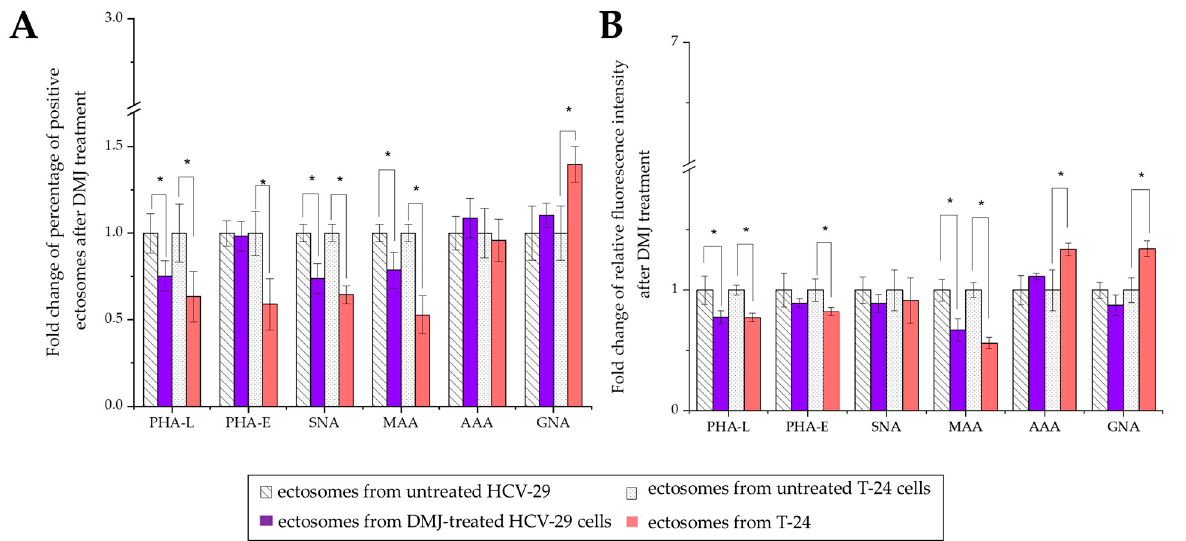
Figure 14. Flow cytometry analysis of surface glycosylation of ectosomes derived from HCV-29 and T-24 cells grown in control conditions or treated with DMJ. ( A ). Diagram showing the fold change of percentage of positive ectosomes in each staining. ( B ). Diagram showing the fold change of relative fluorescence intensity (RFI) for each staining. *—denotes statistically significant differences.